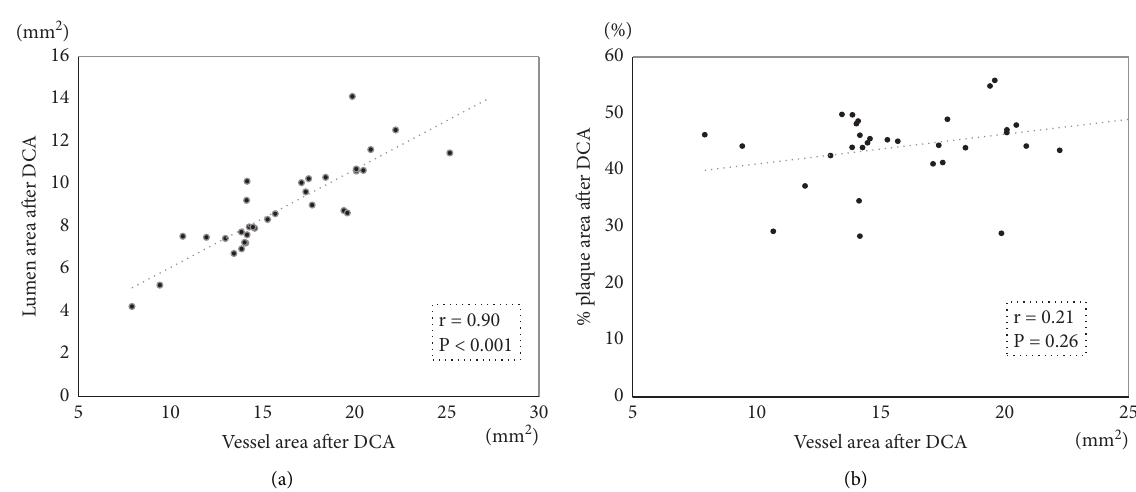
Figure 1: (a) Correlation between the lumen area after DCA and the vessel area after DCA. (b) Correlation between %PA after DCA and the vessel area after